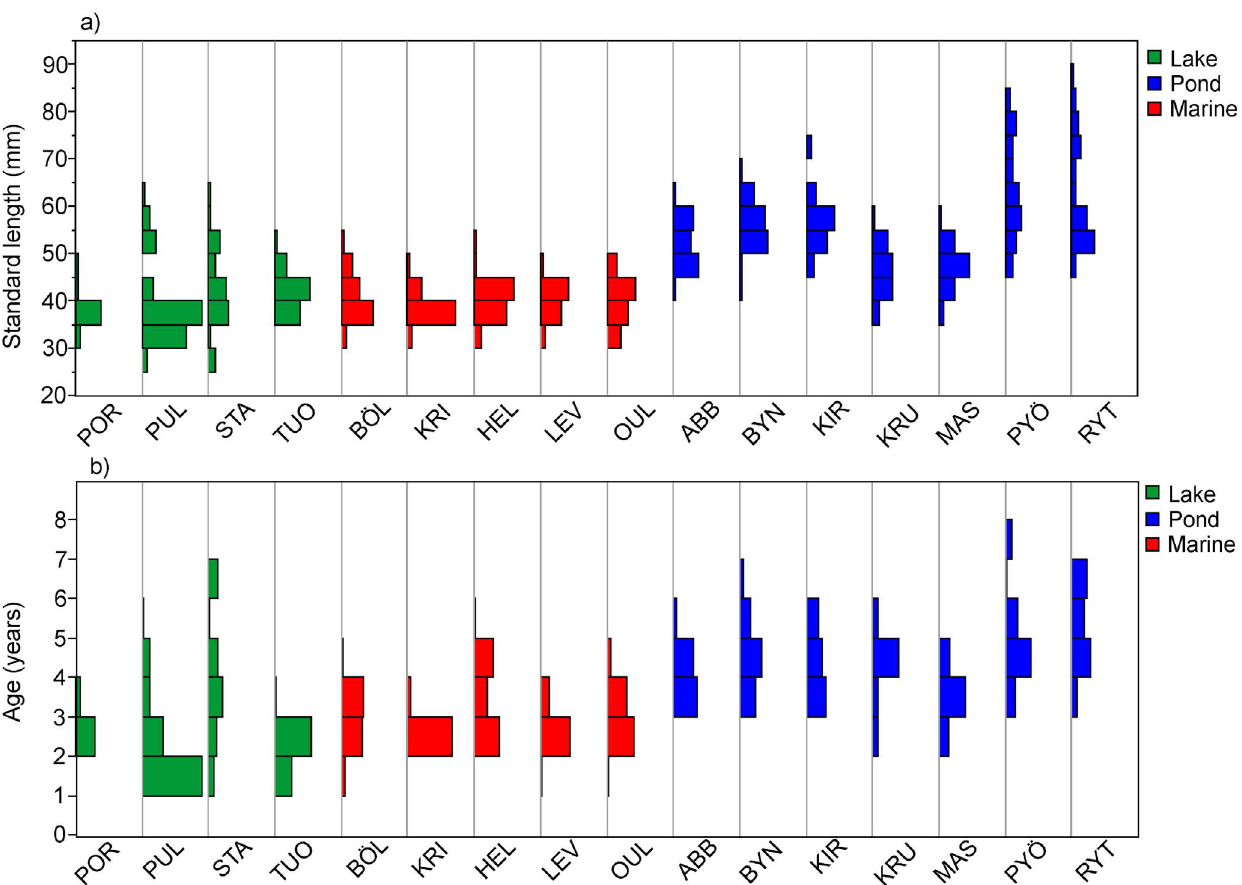
Figure 2. Distribution of (a) body size (standard length) and (b) age of nine-spined sticklebacks in different localities. Green=lakes; blue=ponds; red=marine.